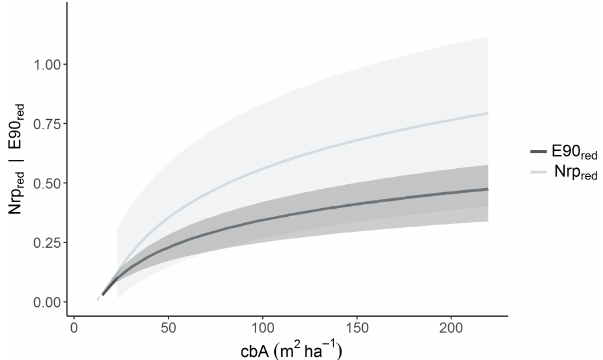
Figure 6. Nrp red (light grey) and E90 red (dark grey) based on the simulation of all forest and terrain scenarios on the concave slope and depending on cbA using a logarithmic smoothing function and the respective 10 and 90% quantiles (shaded).